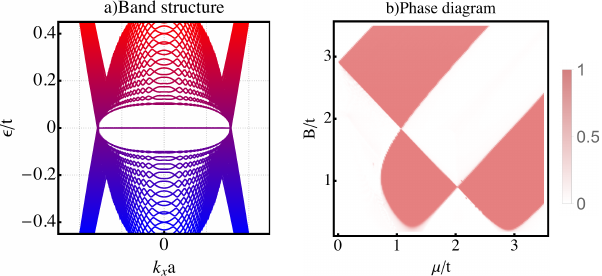
Figure 9: a) Band structure for a graphene nanoribbon with a magnetic field rotating in the plane of the ribbon, with an wave vector 2 π/ 5 d parallel to the edges of the ribbon, for µ = 3 t , B = t and ∆ = 0.2 t , W = 86 a . b) Phase diagram as a function of µ and B for ∆ = 0.2 t , W = 173 a